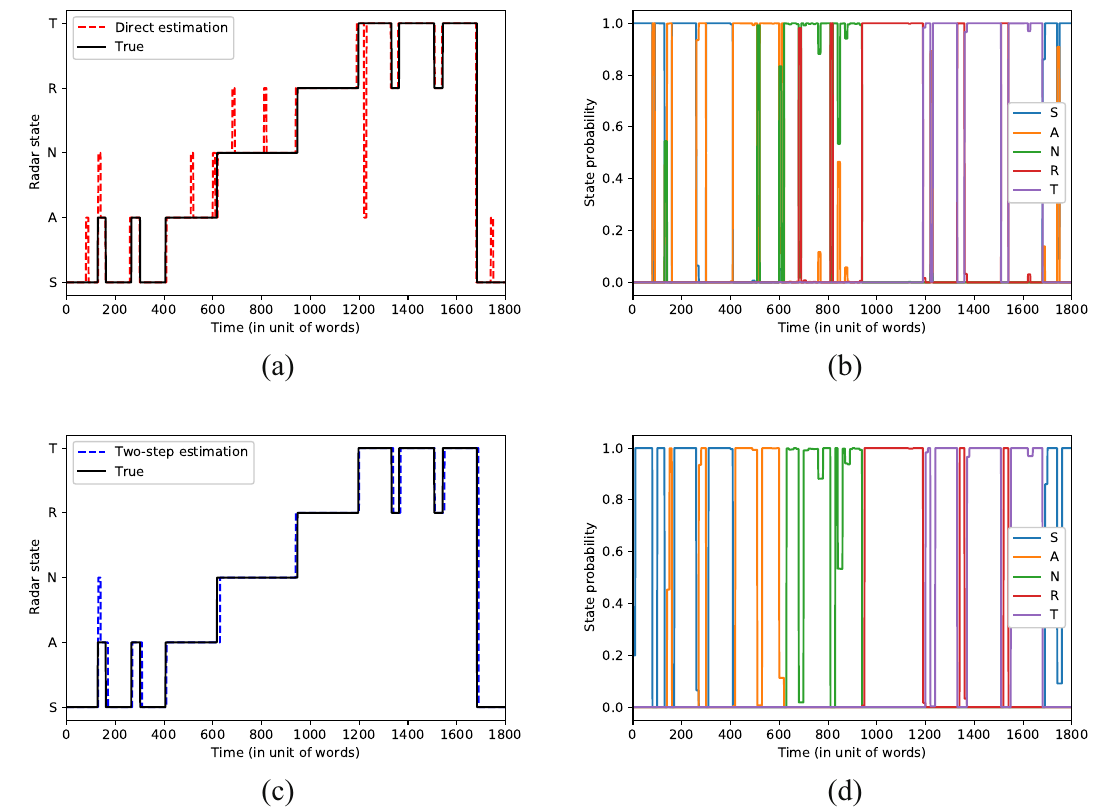
Figure 8. Recognition results of radar states based on the end-to-end network. ( a ) Radar state recognition by direct estimation, ( b ) Probability distribution of radar states by direct estimation, ( c ) Radar state recognition by two-step estimation, ( d ) Probability distribution of radar states by two-step